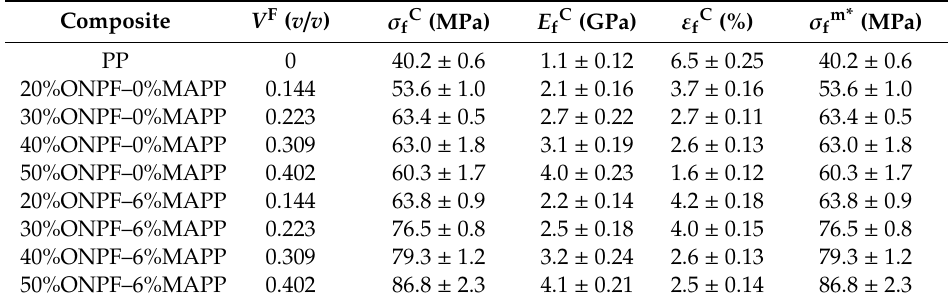
Table 1. Flexural properties of the old newspaper fibers (ONPF) reinforced Polypropylene (PP) composites against reinforcement and coupling agent